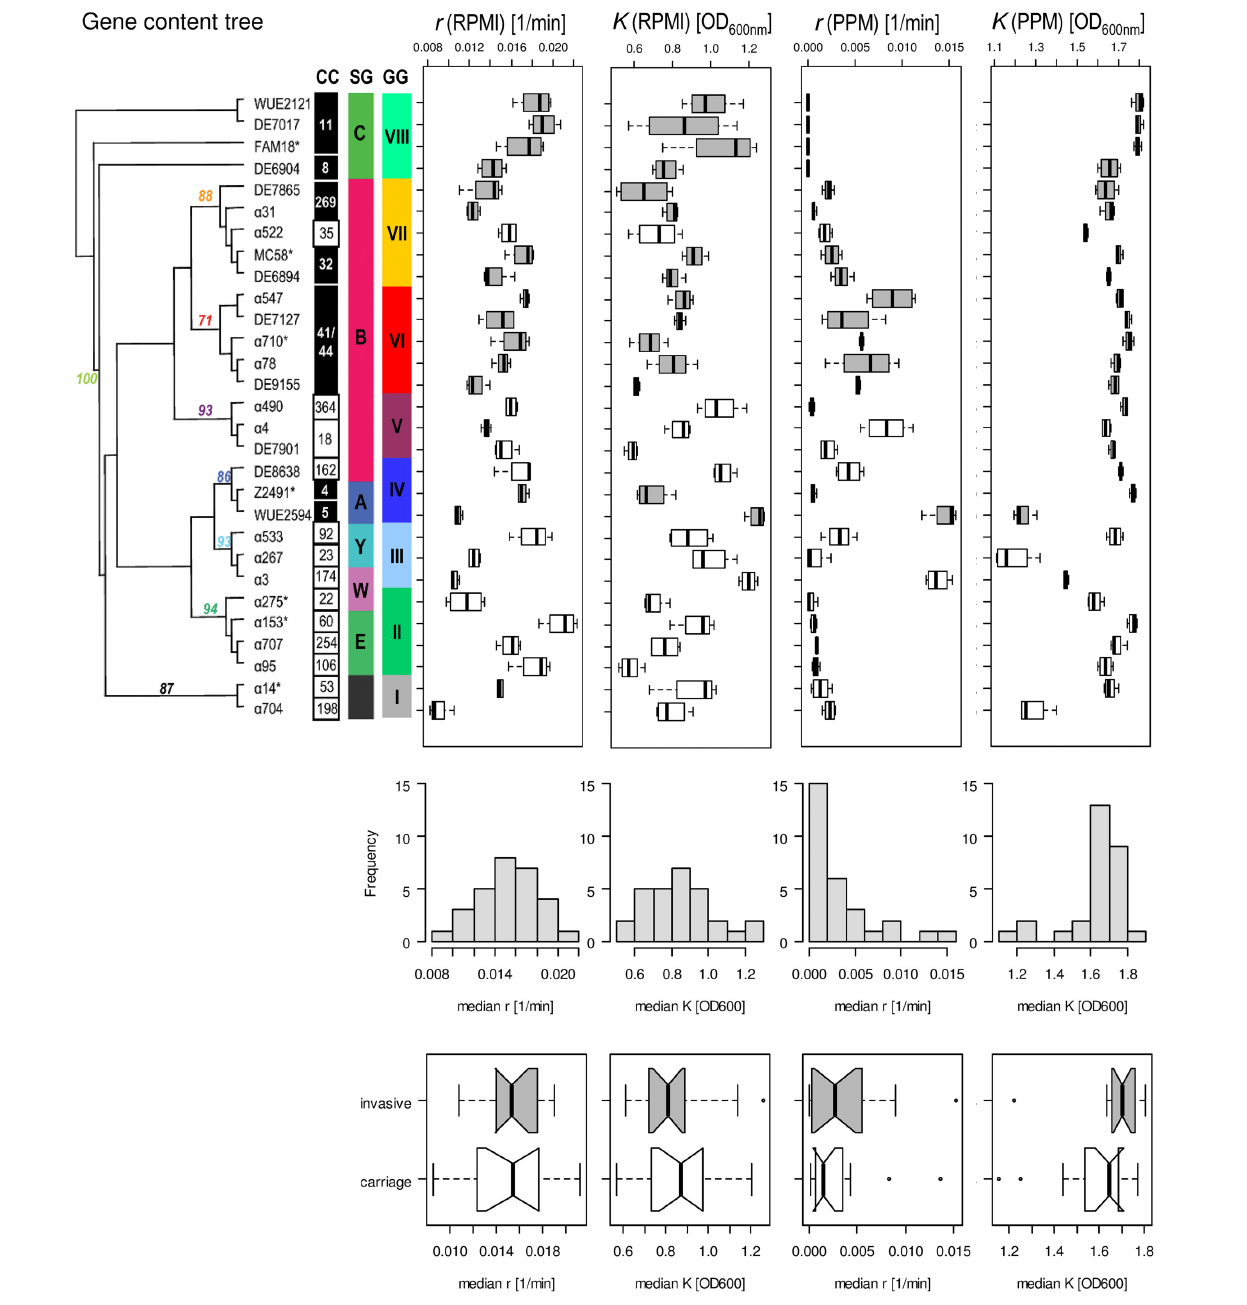
middle of the boxes the corresponding median values. The whiskers show the largest and smallest observations, respectively, and outliers are plotted as individual points. Boxes for strains belonging to hyperinvasive clonal complexes are shaded in dark gray. In the middle panel, histograms with the marginal distributions for the median growth rates and capacities in RPMI and in PPM, respectively, are given. In the bottom panel, box-and-whiskers-plots comparing the distributions of the respective median values for strains from carriage and hyperinvasive lineages are shown. For each strain and condition, growth measurements were repeated four times (technical replicates) and from the fitted curves the two parameters r and K were determined for each growth experiment